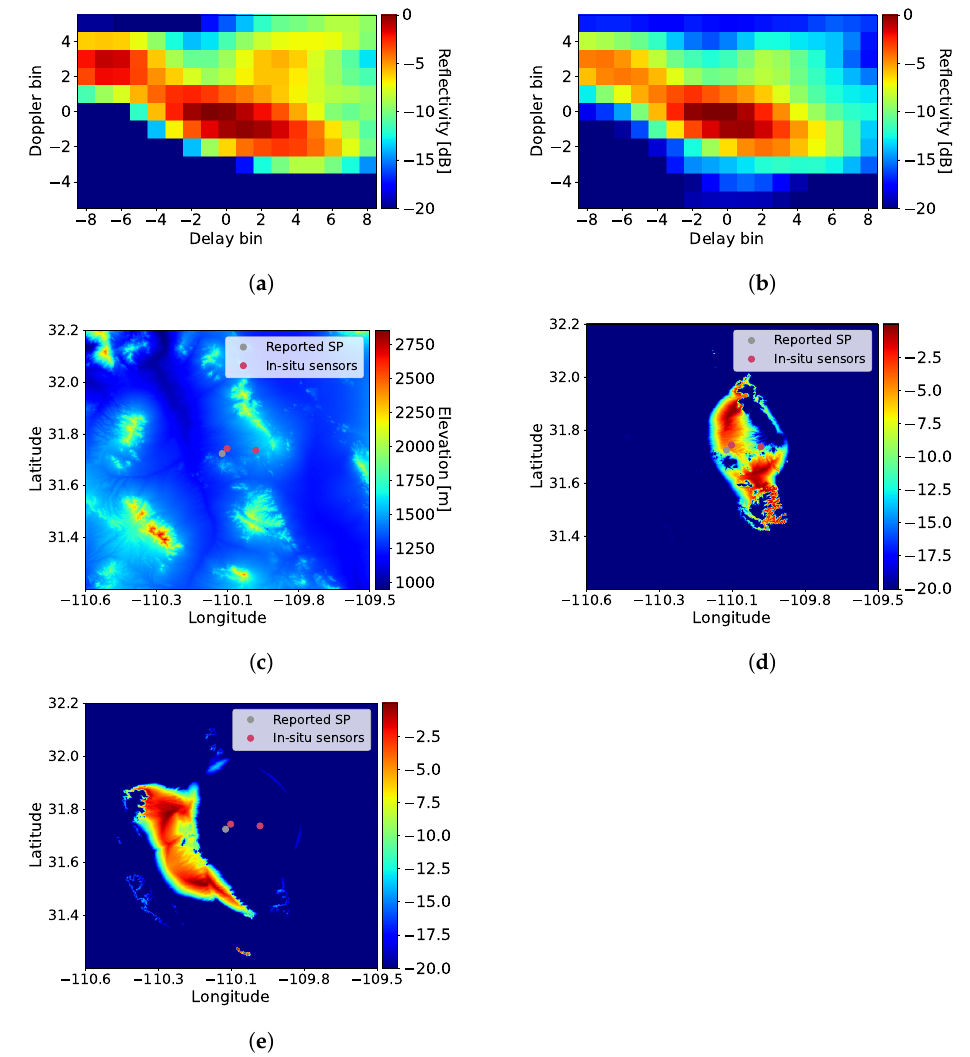
Figure 11. DDM of sample 70,693 of WG track 1: ( a ) Normalized CYGNSS DDM; ( b ) Normalized IGOT DDM; ( c ) DEM; ( d ) WAF projection of DDM cell ( − 7, 3); ( e ) WAF projection of DDM cell (0, 0). The third DDM is sample 104,027 of JER track 1. Its SP is located at 32.553 ◦ latitude and − 106.771 ◦ longitude with an SNR of 8.7 dB. This DDM was selected due to its proximity to the in situ sensors and the SP footprint location. Figure 12d shows the elevation map of the area around the SP. Furthermore, the normalized CYGNSS DDM and IGOT model DDM are presented in Figure 12a,b, respectively. These figures show that the DDM of the IGOT model has a similar shape as the CYGNSS DDM. Furthermore, the WAF projection map of the SP matches the expected shape of a flat region, as shown in Figure 12c. A WAF projection map of a SP of a flat area is expected to have an elliptical